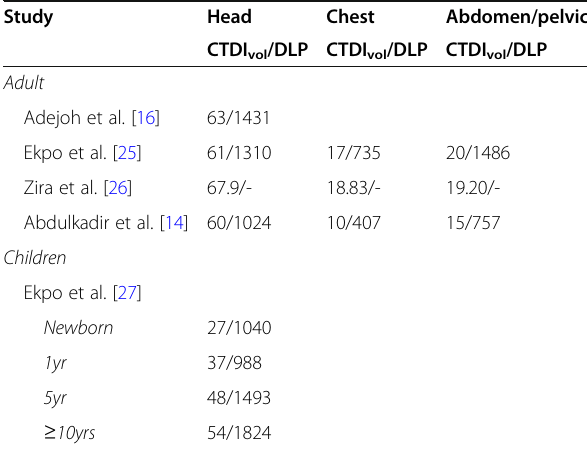
Table 2 Typical local CT DRL values (75th percentile) for common CT examinations in the study